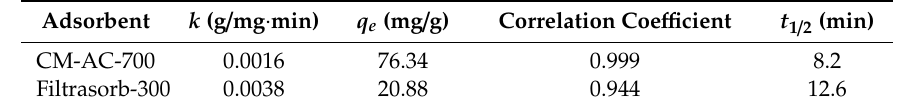
a Adsorption conditions: initial MB concentration = 10 mg/L, adsorbent dosage = 0.3 g/2 L, agitation speed ＝ 200 rpm, and temperature ＝ 25 °C.